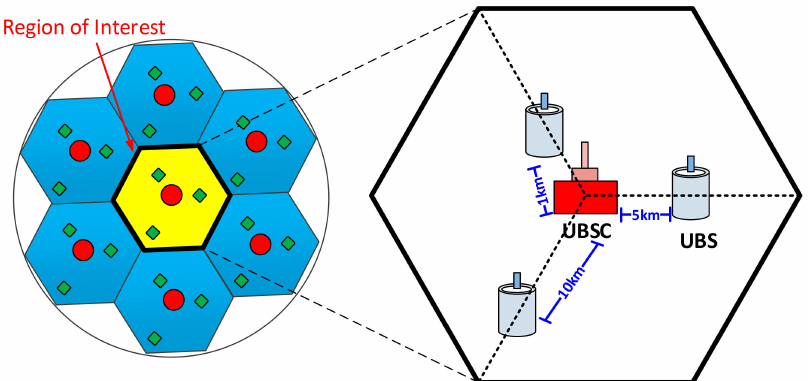
Figure 1. Cellular layout for an underwater acoustic communications (UAC) network. UBSC: underwater base station controllers; UBS: underwater base stations.